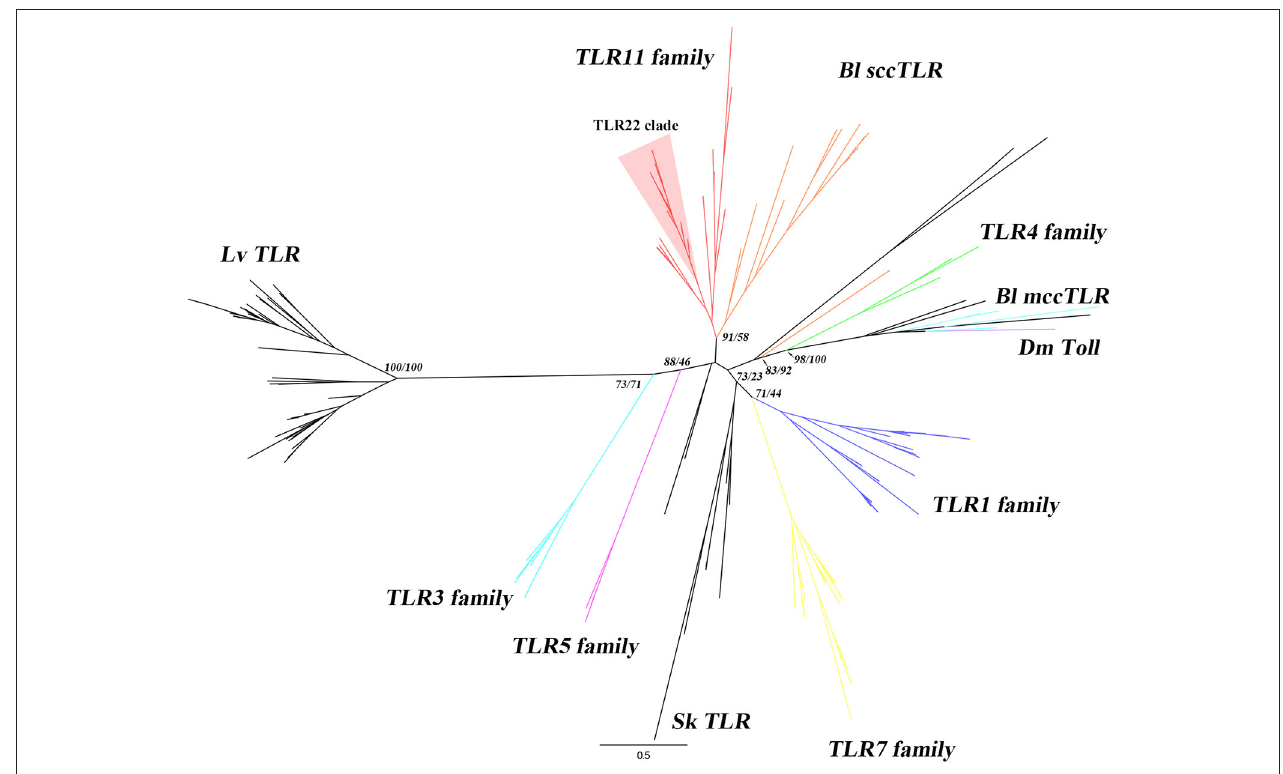
FIGURE 1 | Phylogenetic analysis of B. lanceolatum TLRs. The phylogenetic tree was constructed using maximum-likelihood (IQ-TREE) with the full-length protein sequences. TLR sequences of B. lanceolatum , S. kowalevskii , L. variegatus , representative vertebrates and D. melanogaster Toll were used. Three TLR sequences (Bl10262, Bl22164 and Bl08928c) with incomplete TIR domain were removed from the analysis. Sequences were aligned with MAFFT choosing L-INS-i method and the alignments were trimmed using TrimAL with “Automated 1” mode. The best evolutionary model was established by ModelFinder according to BIC. The branch labels (numbers) are SH-aLRT support (%)/ultrafast bootstrap support (%) at the tree nodes. The tree was generated in FigTree. Dm Toll, Bl mccTLRs, Bl sccTLRs, Sk TLR, Lv TLR and 6 vertebrate TLR families (highlighted in different colors) are shown. TLR22 clade is shown with a red background. The detailed tree with all node supports can be found in Supplementary Figure 2